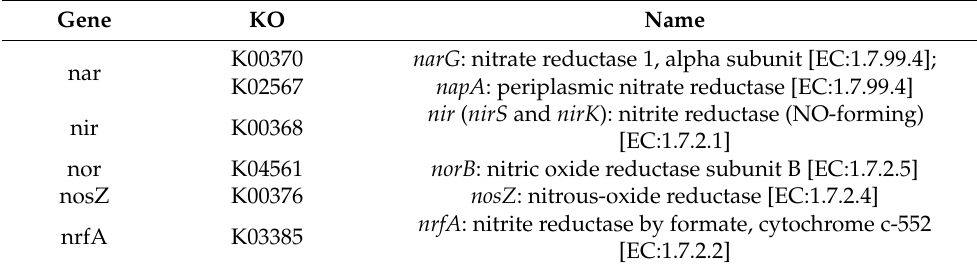
Table A2. Functional genes associated with dissimilatory nitrate reduction, as retrieved from the KO database (Kanehisa et al., 2004). narG was chosen as the marker for the gene cluster narGHI and napA as the marker for the gene cluster napABCDE